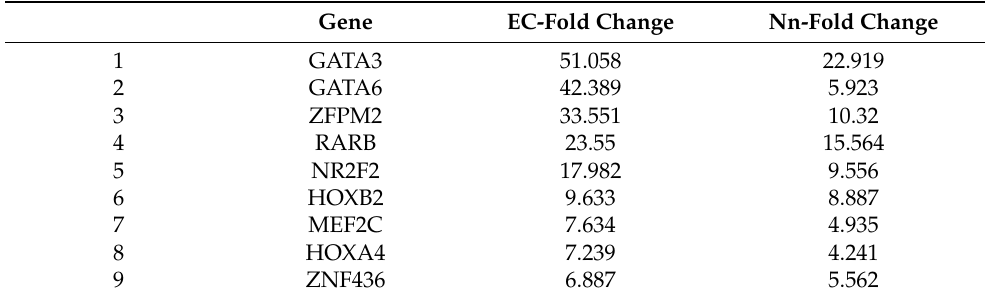
Table 1. Genes in transcription factor category that are upregulated in both endothelial and neu- ral cells.